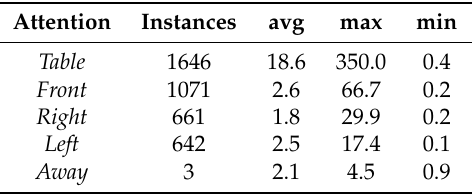
Table 1. Annotation results for the attention target of the participants of the data corpus: the columns, “avg,” “max,” and “min” shows the average, maximum, and minimum duration in seconds, respectively. Attention Instances